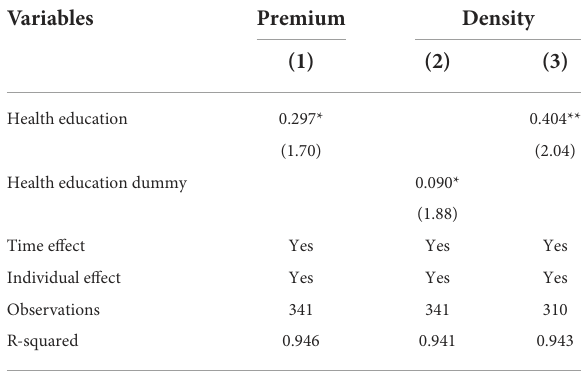
TABLE 4 Robust test